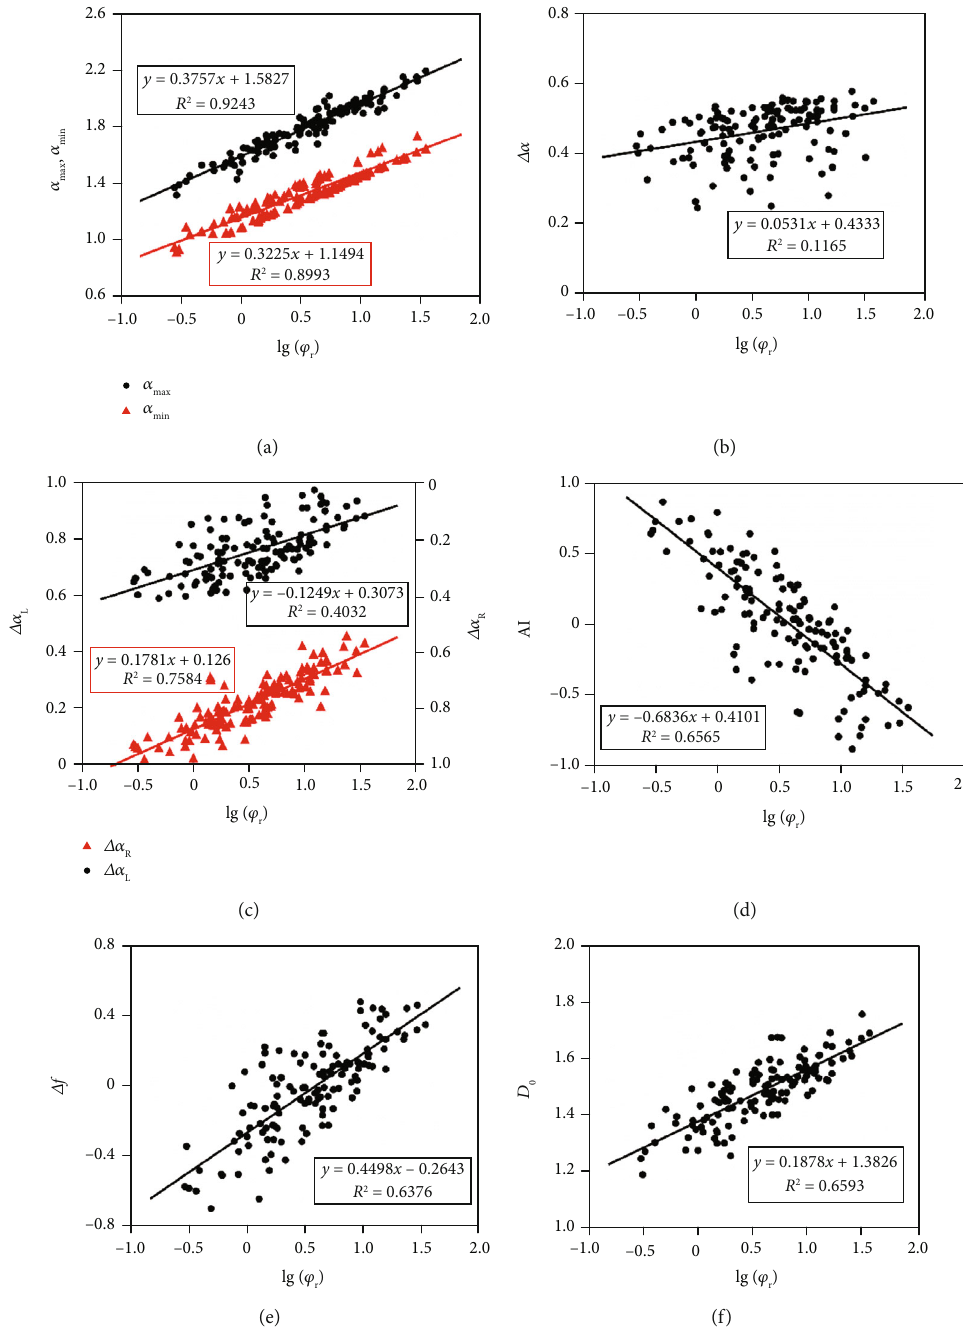
α min and max and